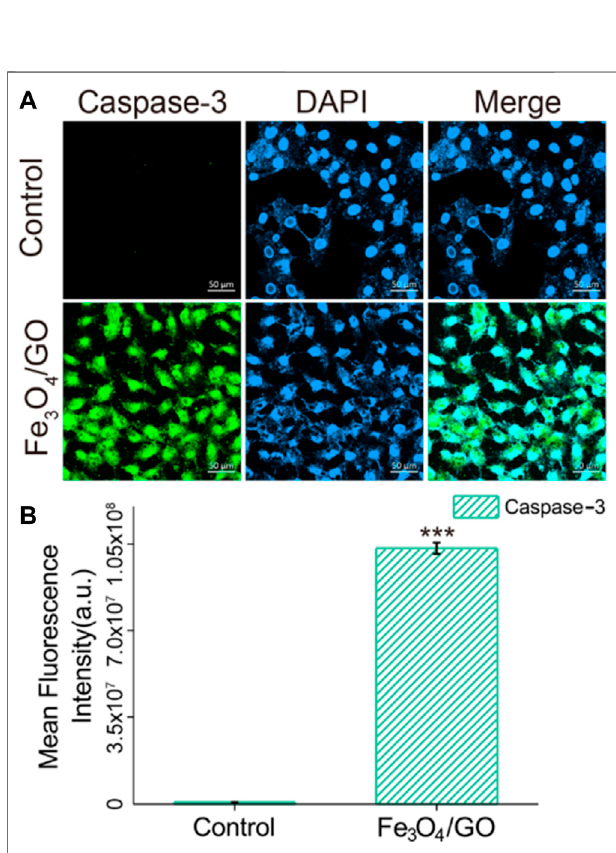
FIGURE 11 | (A) Immune fl uorescence of Caspase-3 after Fe 3 O 4 /GO exposure. (scale bar: 50 μ m) (B) Mean fl uorescence intensity of Caspase-3 after Fe 3 O 4 /GO